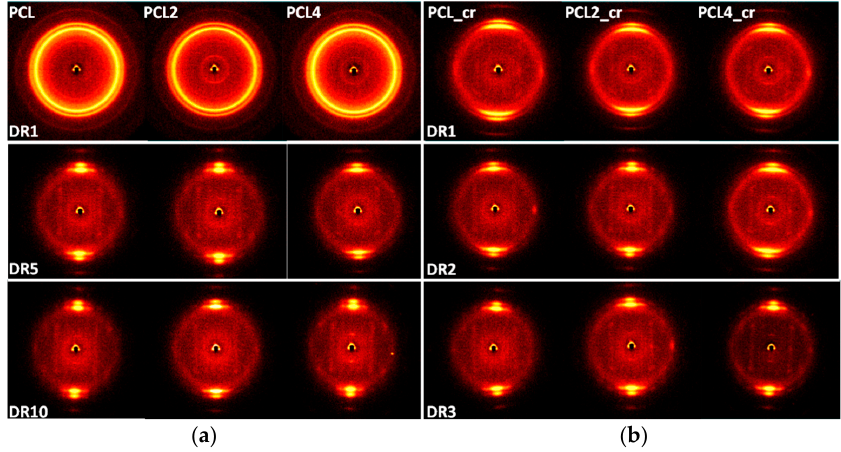
Figure 10. 2D WAXD images recorded through-thickness of the films. ( a ) Films cooled with open chill rolls and ( b ) films cooled with closed chill rolls. The drawing direction is horizontal in the images.